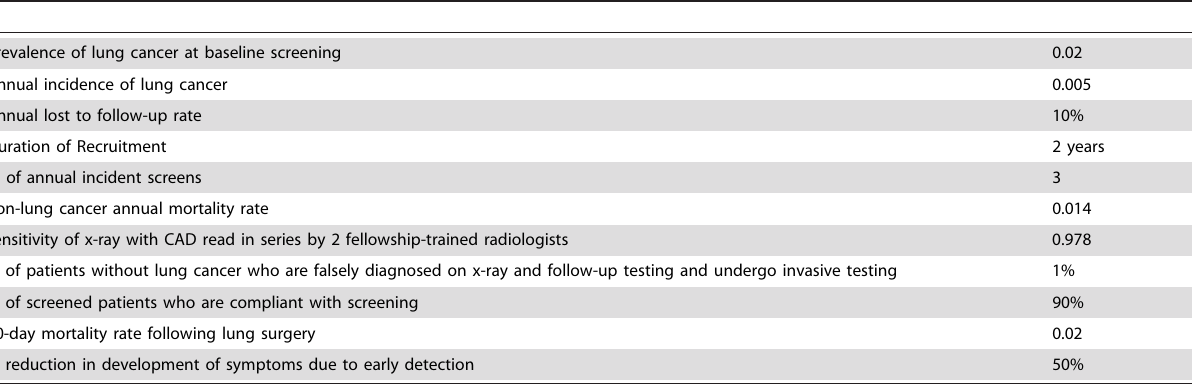
Table 1. The assumptions made in calculating the required sample size for this study.